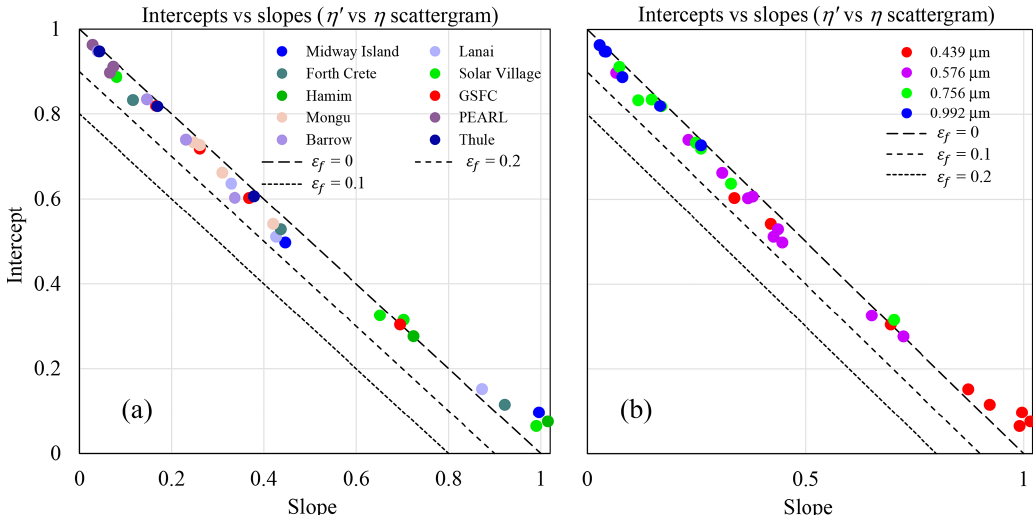
Figure 7. Intercept vs. slope plots for the η (cid:48) vs. η scattergrams as a function of (a) all the sites of Table 1 and (b) the cutoff r 0 value (AERinv inflection point radius). The black dashed or pointed lines represent the family of straight lines generated by Eq. (7a): slope = ( 1 − ε c − ε f ) and intercept = ε c for values of ε c = 0 to 1 and three values of ε f (0.0, 0.1 and 0.2). Table 2. η ’ vs. η regression stats for r 0 = 0 . 439µm a .